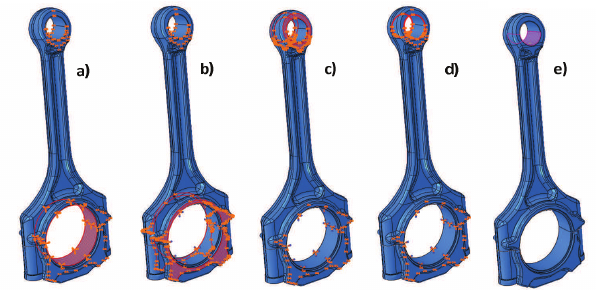
Fig. 3. Boundary conditions of restraints and forces acting on the model